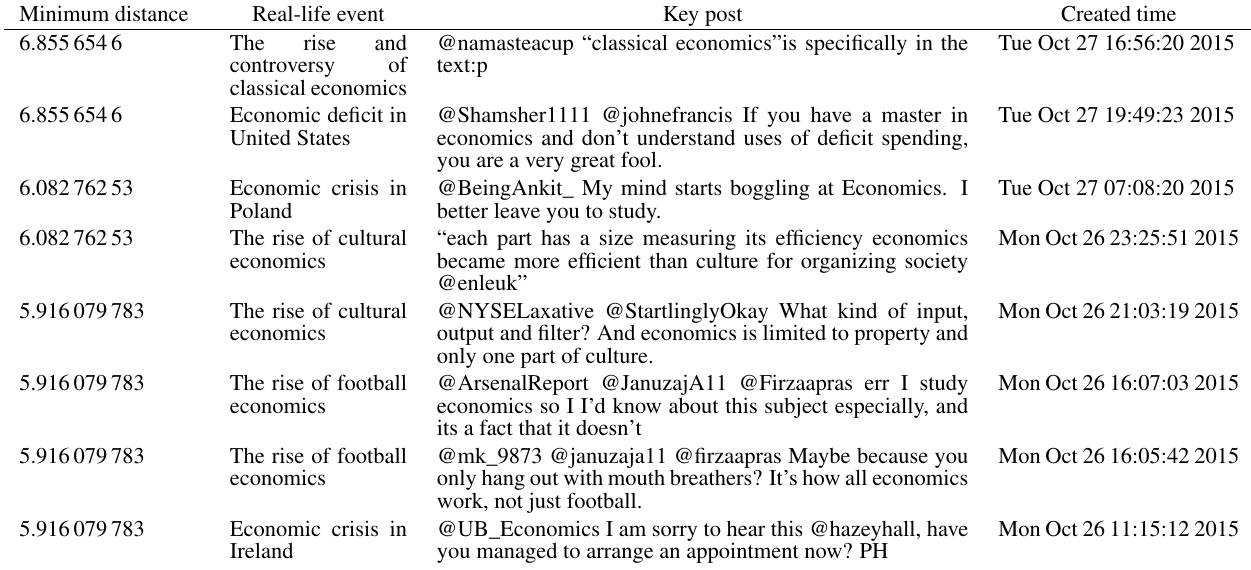
Fig. 6 Number of topics from the TD-HITS method. Table 3 Evaluation results for event